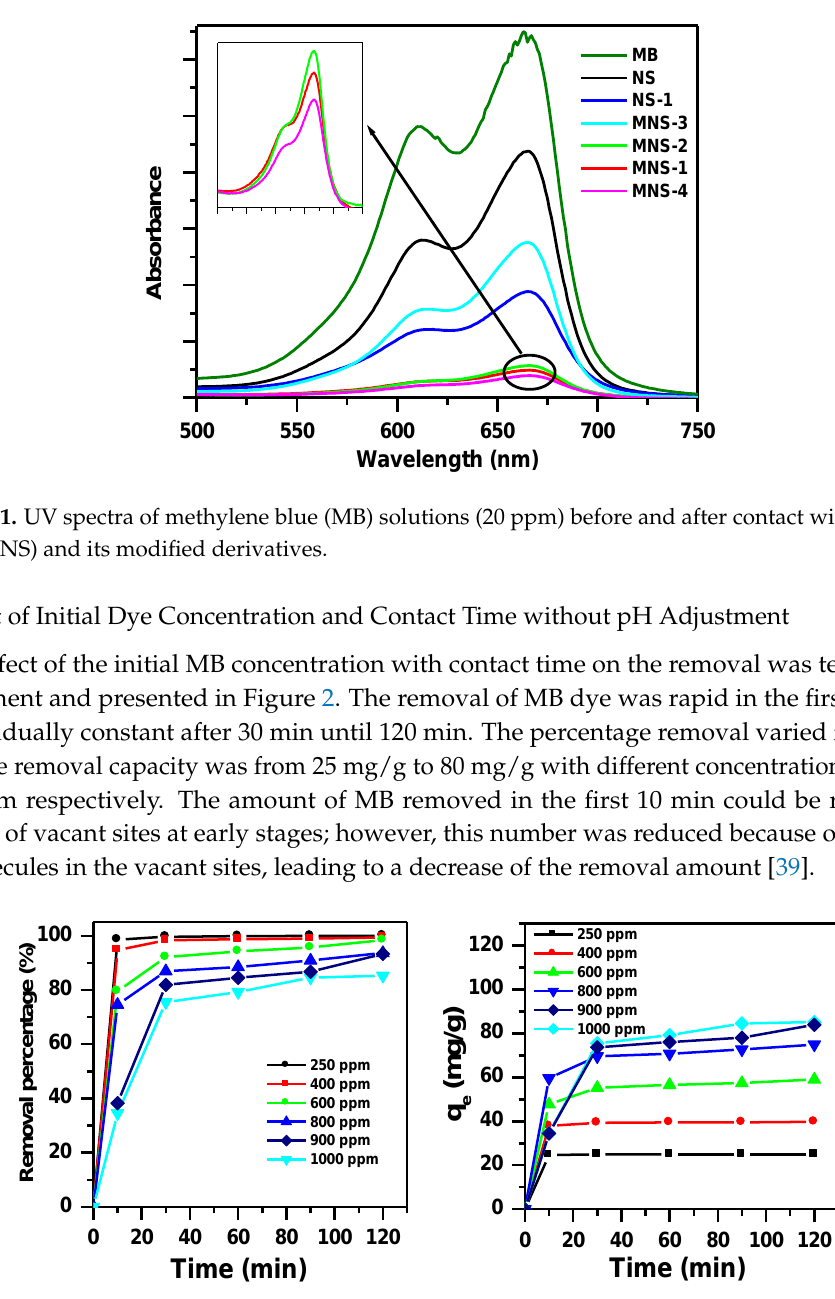
Figure 2. Effect of initial dye concentration and contact time on the removal efficiency of MB using MNS-4.